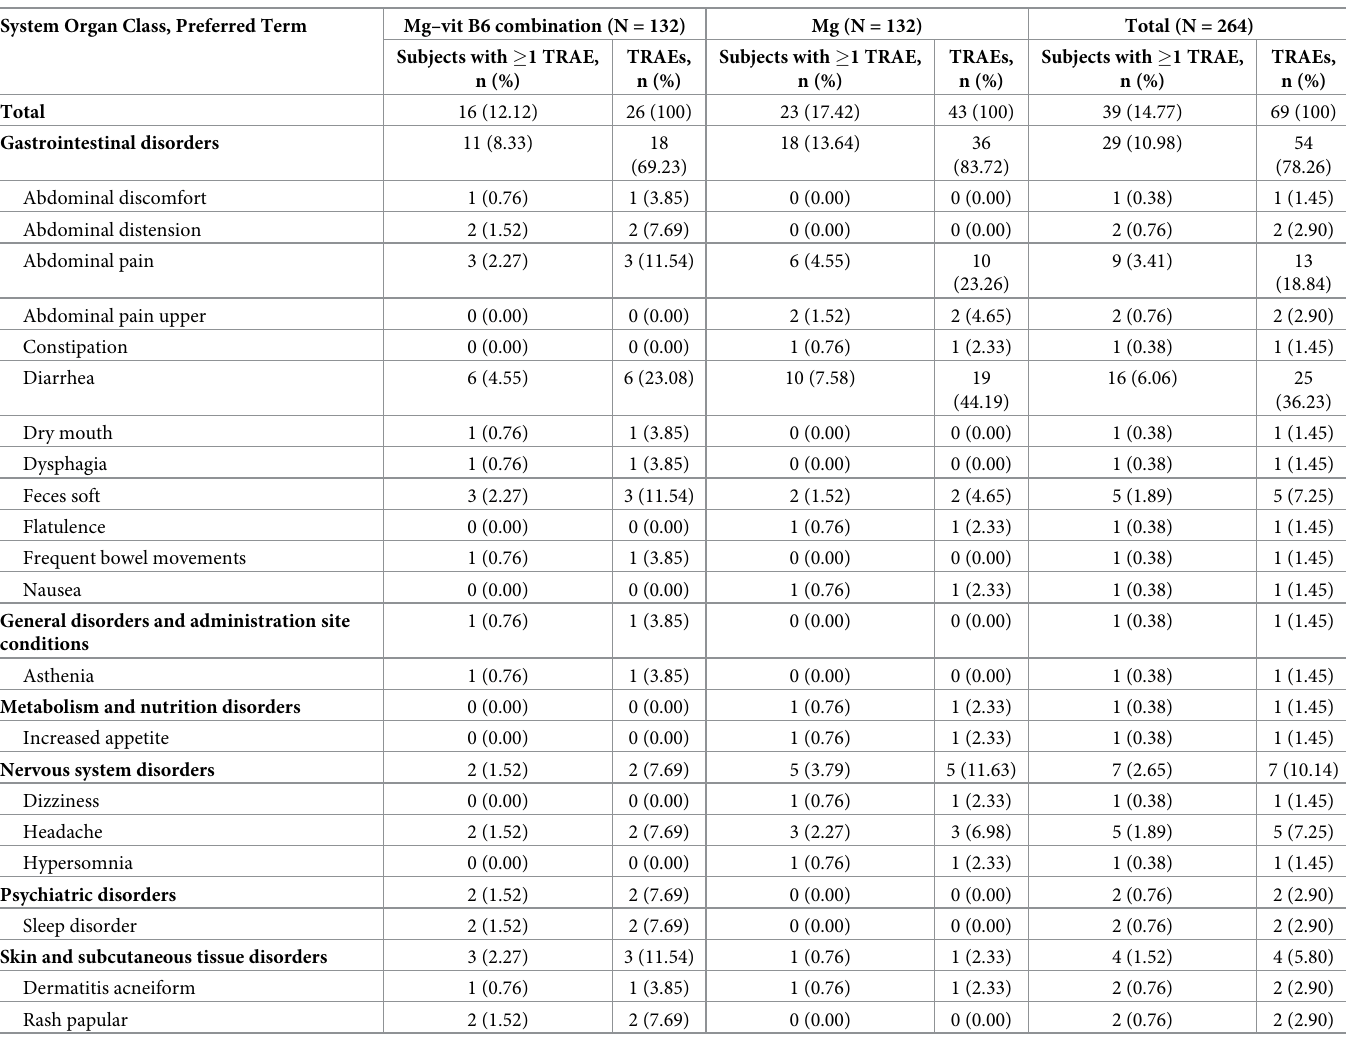
Table 5. Treatment-related adverse events occurring in � 1% of the total population